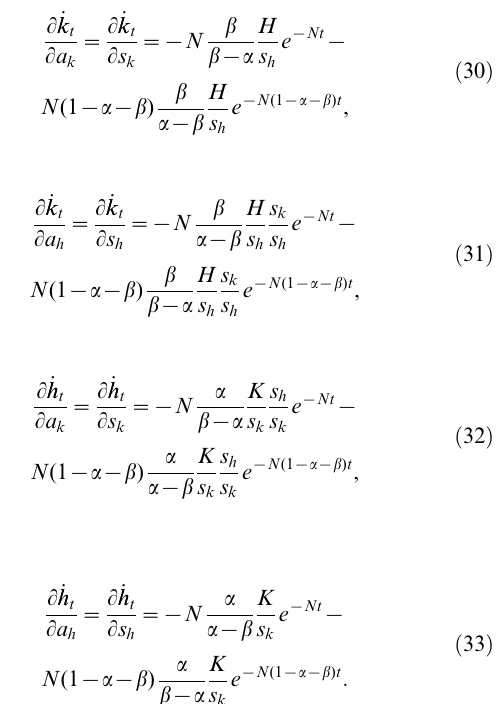
Equations (20)–(23) and (30)–(33) offer an insight about the role (or